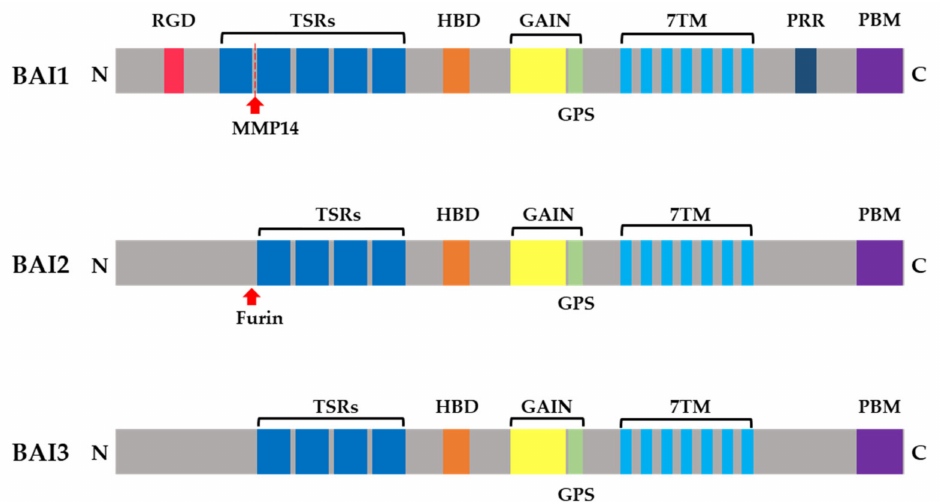
Figure 1. A schematic diagram of protein primary structures of the brain-specific angiogenesis inhibitor (BAI) subfamily (various functional domains). RGD, Arg-Gly-Asp integrin-binding motif; TSR, thrombospondin type 1 repeat; HBD, hormone-binding domain; GAIN, GPCR autoproteolysis-inducing domain; GPS, GPCR proteolytic site; 7TM, seven-transmembrane regions; PRR, proline-rich region; PBM, PDZ-binding